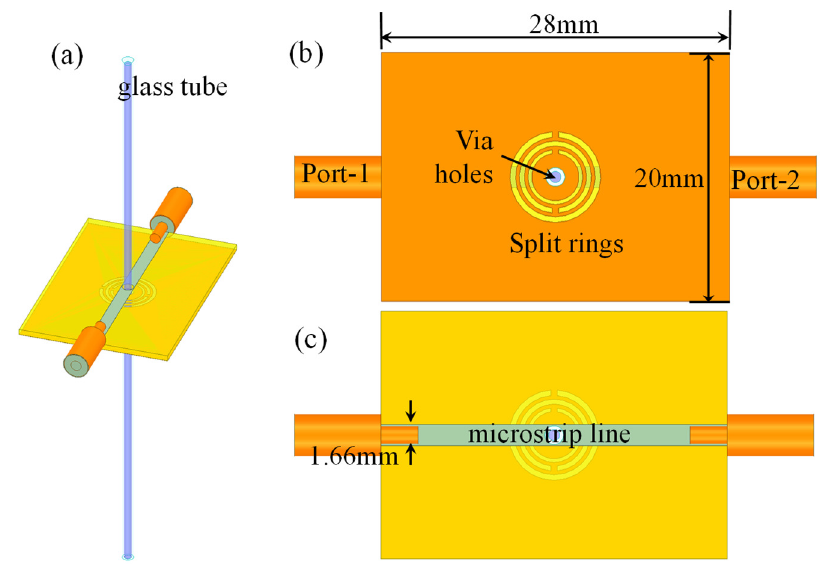
Figure 1. Circular CSRR ( a ) a 3D illustration; ( b ) Top view; ( c ) Rear view.